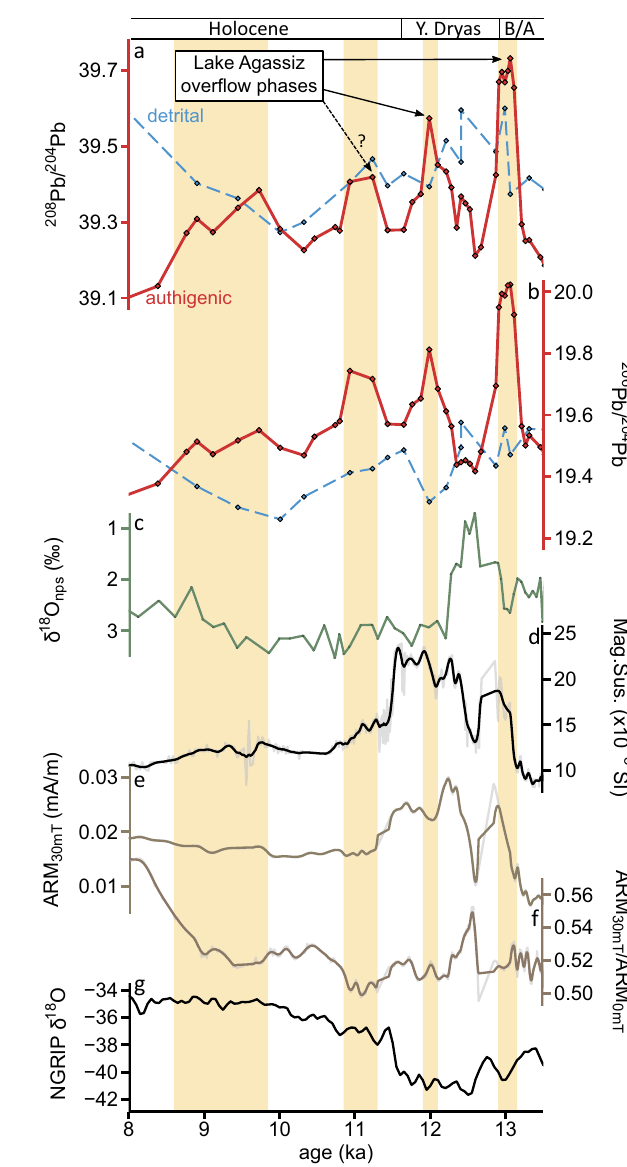
Fig. 4 Geochemical and bulk sediment properties of core HLY1302 JPC- 15/27 for the late Bølling – Allerød, the Younger Dryas and early Holocene. Data are shown against age (ka). a and b Authigenic (red) as well as detrital (dashed blue) 208 Pb/ 204 Pb ( a ) and 206 Pb/ 204 Pb ( b ) signature. c Stable oxygen isotope data ( δ 18 O) in ‰ of planktonic foraminifera N. pachyderma s . and d magnetic susceptibility 6 . e ARM 30mT record of JPC-15/27 complemented with f the ARM 30mT /ARM 0mT ratio of the same samples. g NGRIP δ 18 O 69 . Light yellow areas indicate major Lake Agassiz drainage events through the Mackenzie